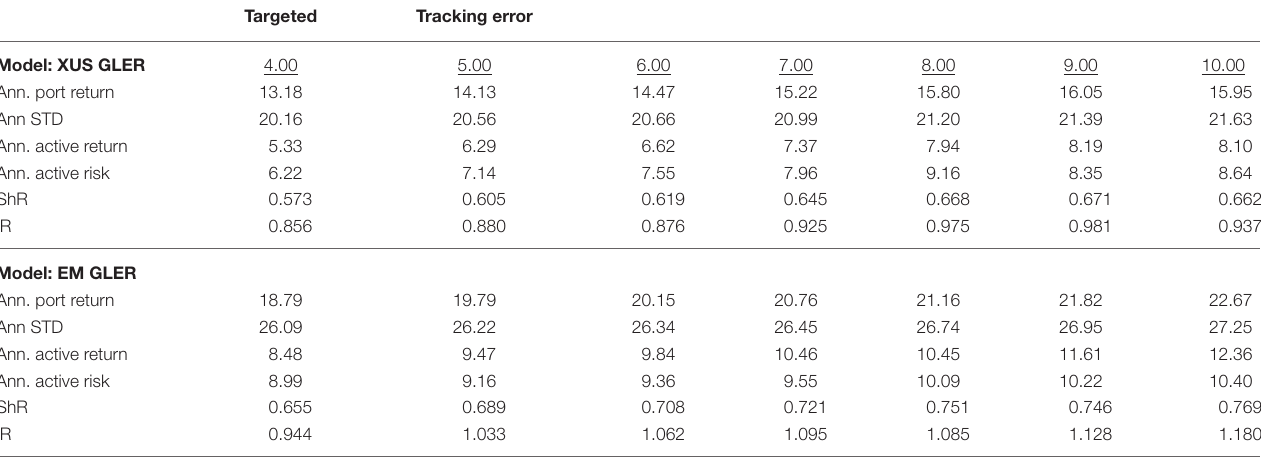
TABLE 2 | Portfolio return, risk, and performance characteristics. Targeted Tracking